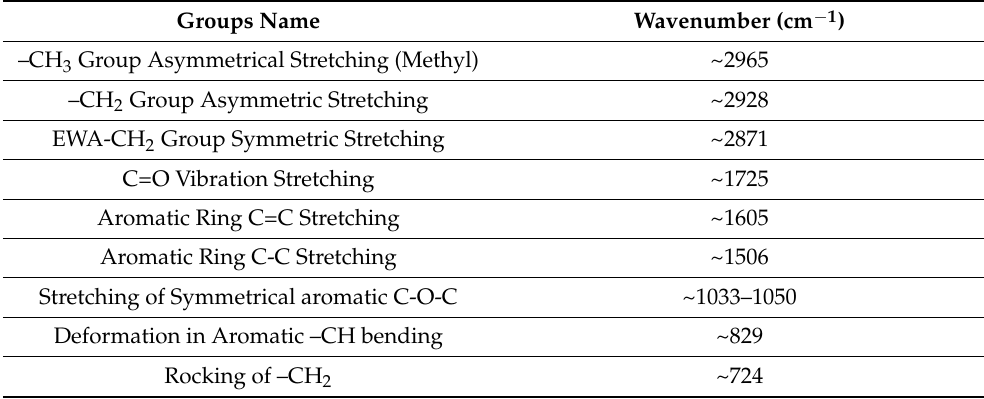
Table 1. FTIR bands assigned to epoxy.